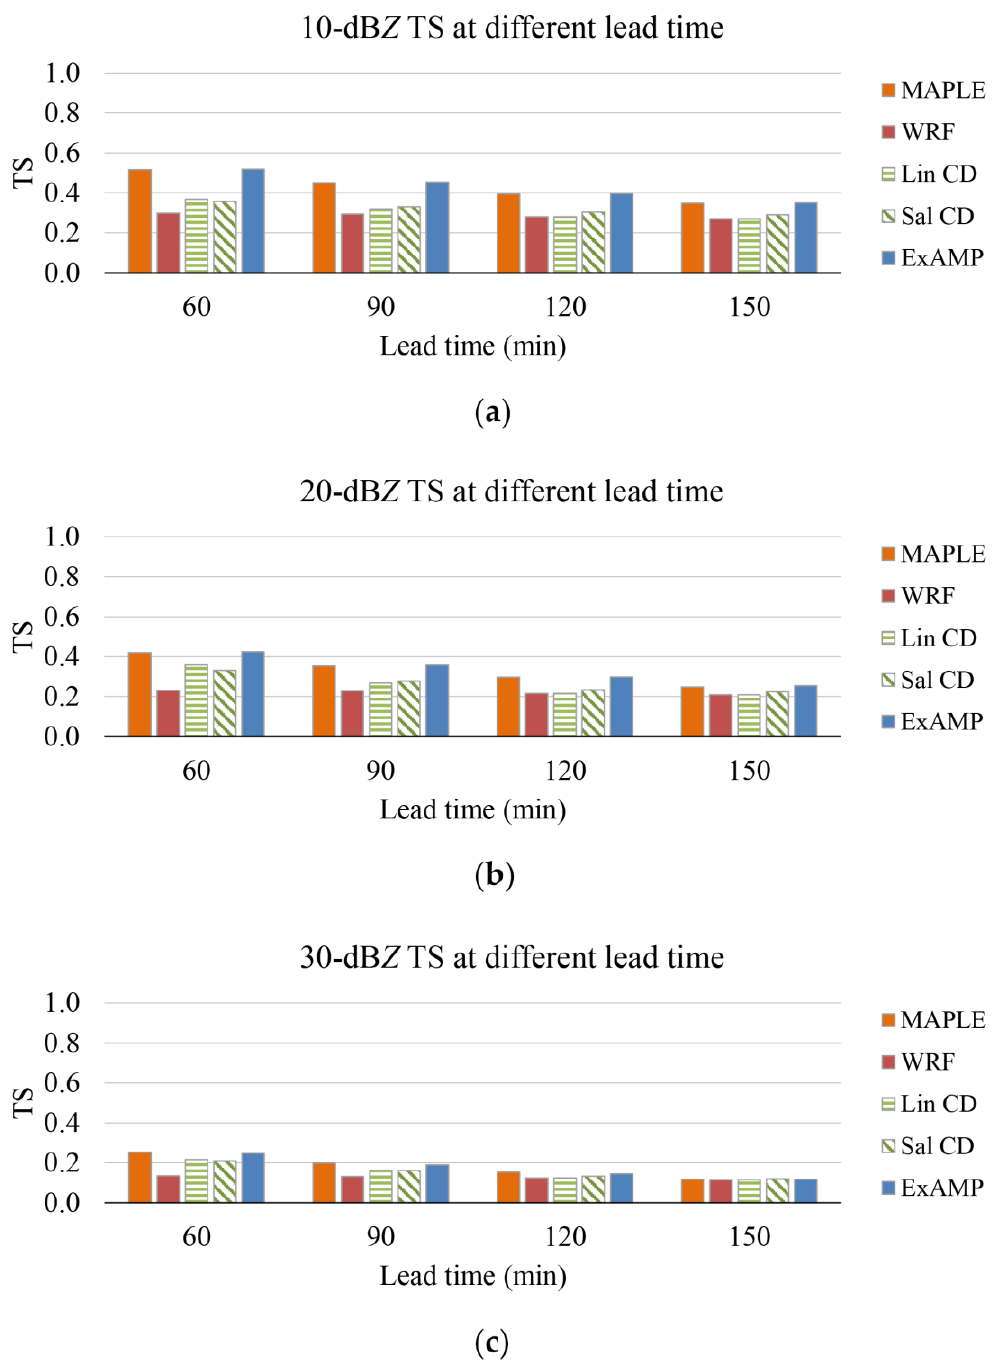
Figure 6. The threat scores (TSs) of MAPLE, WRF, Lin CD, Sal CD, and ExAMP above ( a ) 10, ( b ) 20, and ( c ) 30 dB Z thresholds at the lead times of 90, 120, and 150 min, computed over the grid points with observed reflectivity exceeding 0 dB Z for the 43 periods.